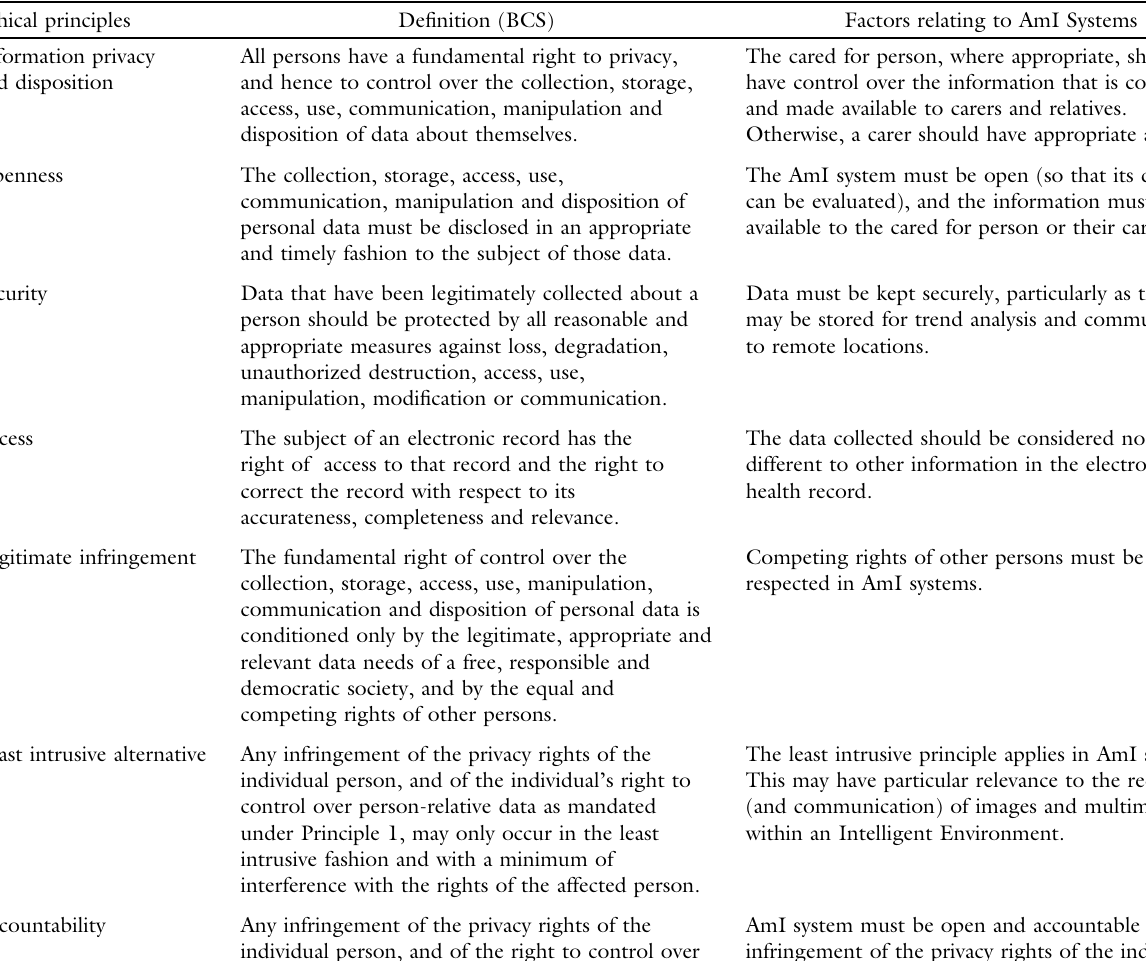
Table 1. Informatics ethics and AmI